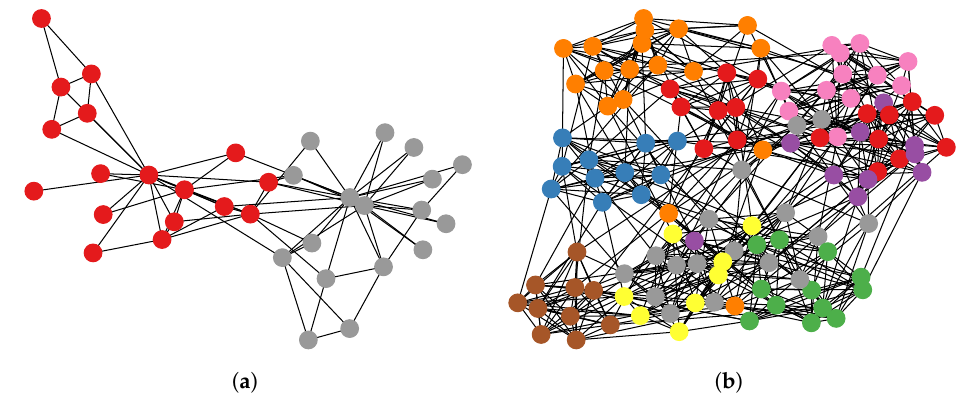
Figure 4. Topology of community network datasets ( a ) Karate club and ( b ) Football. Table 4. Information of community network datasets Karate club and Football. Property Karate Club Football Nodes 34 115 Edges 78 613